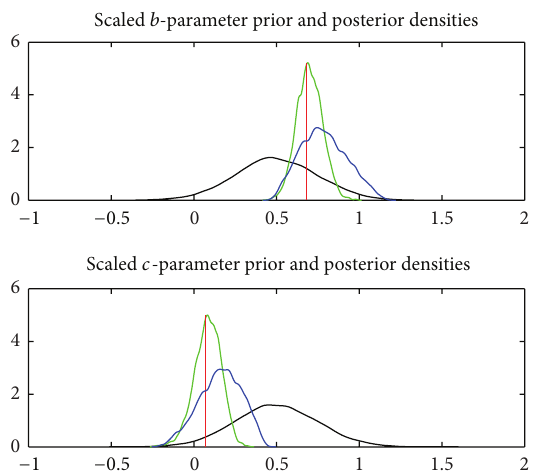
Figure 13: 1-component FFGP-based uncertain input posterior distributions (black: prior, blue: emulator-based posterior, green: computer code-based posterior, and red: true value).